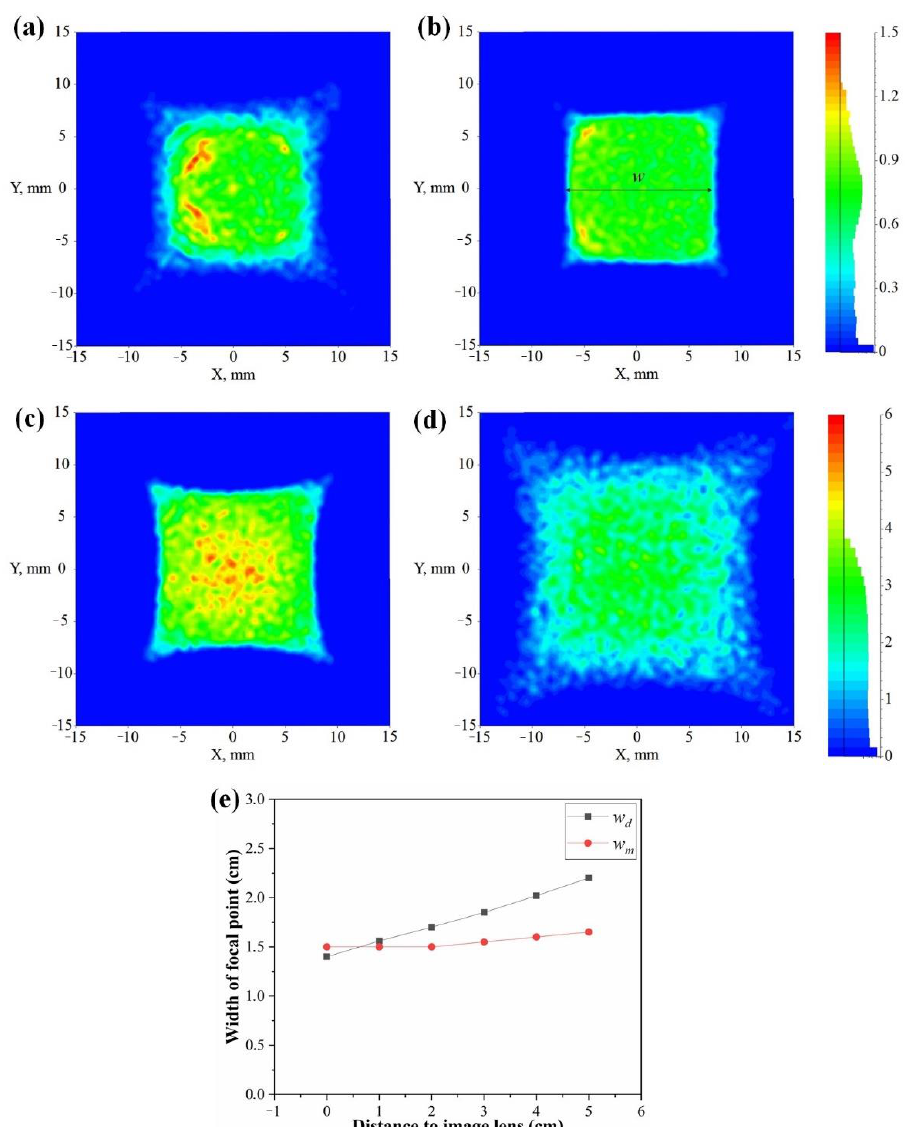
Figure 9. Light distribution on the receiver plane using monochromatic source (λ = 550 nm) at a distance away from the image lens: ( a ) 1 cm; ( b ) 5 cm. Light distribution on the receiver plane using solar light source at a distance away from the image lens: ( c ) 1 cm; ( d ) 5 cm. ( e ) Graph summarizes the relation between distance to image lens and with of focal point in both cases: monochromatic and solar light source.